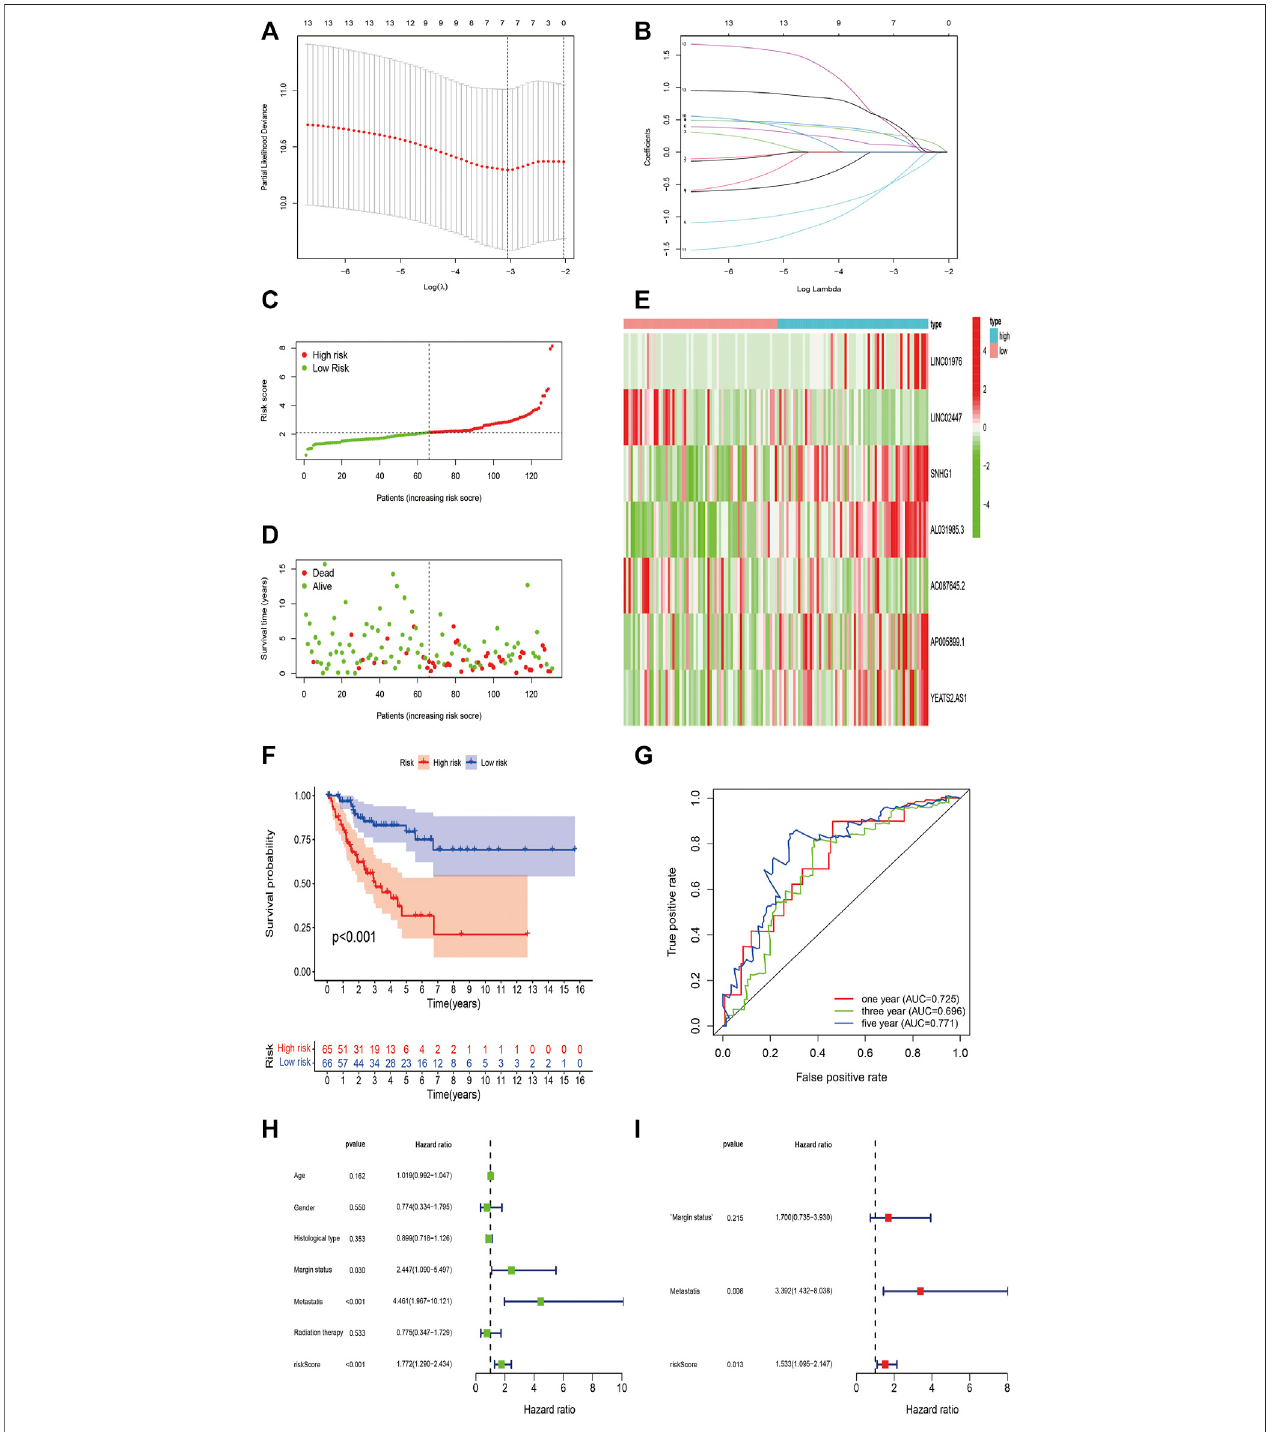
FIGURE 6 | Construction of m6A-Related lncRNAs-Based Risk Signature in STS. (A,B) LASSO analysis with minimal lambda value. (C,D) Risk score and survival statusofeachpatientinthetrainingcohort. (E) Heatmapof7m6A-relatedlncRNAsinthetrainingcohort. (F) Kaplan – Meieranalysisofpatientsinthehighriskandlowrisk groupsinthetrainingcohort. (G) Time-dependentROCanalysisofriskscoreinpredictingprognoses. (H,I) UnivariateandmultivariateCoxanalysesoftheriskscoreand clinical variables in the training cohort.